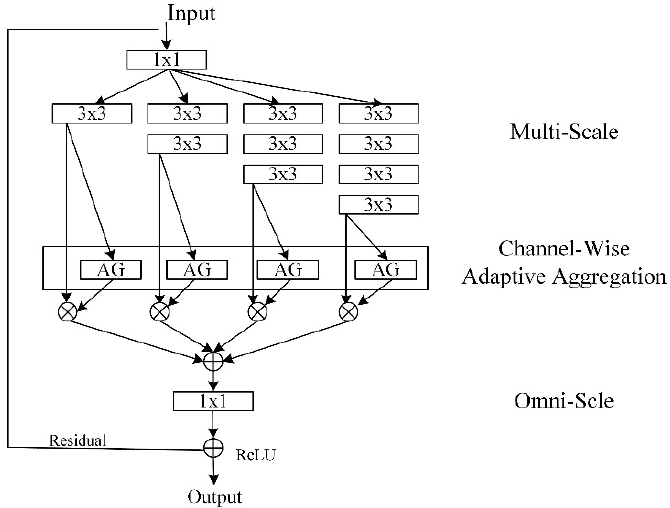
Figure 2. Schematic of the building block for the Omni-scale Network.